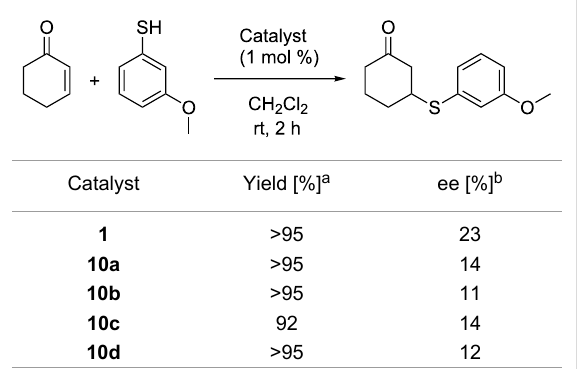
Table 1: Polymer-supported quinines in asymmetric Michael addition.